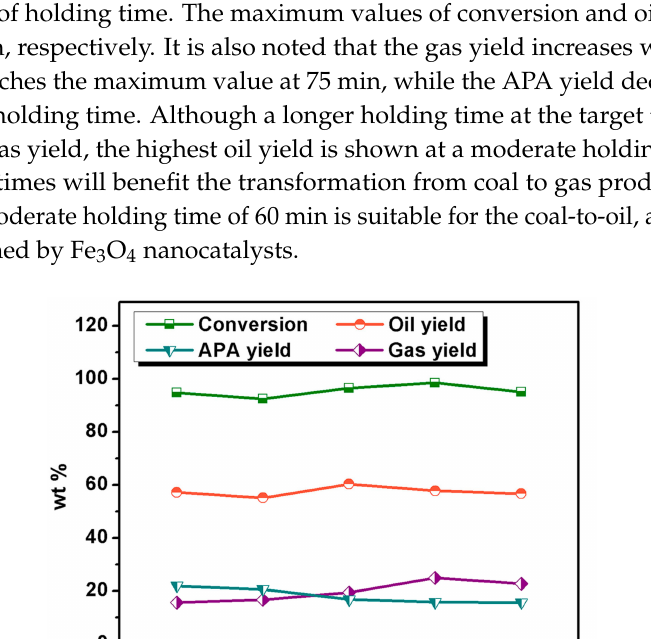
Figure S1: Nitrogen adsorption-desorption isotherm of Fe 3 O 4 nanoparticles, Table S1: Summary of catalytic activities for the direct coal liquefaction with various